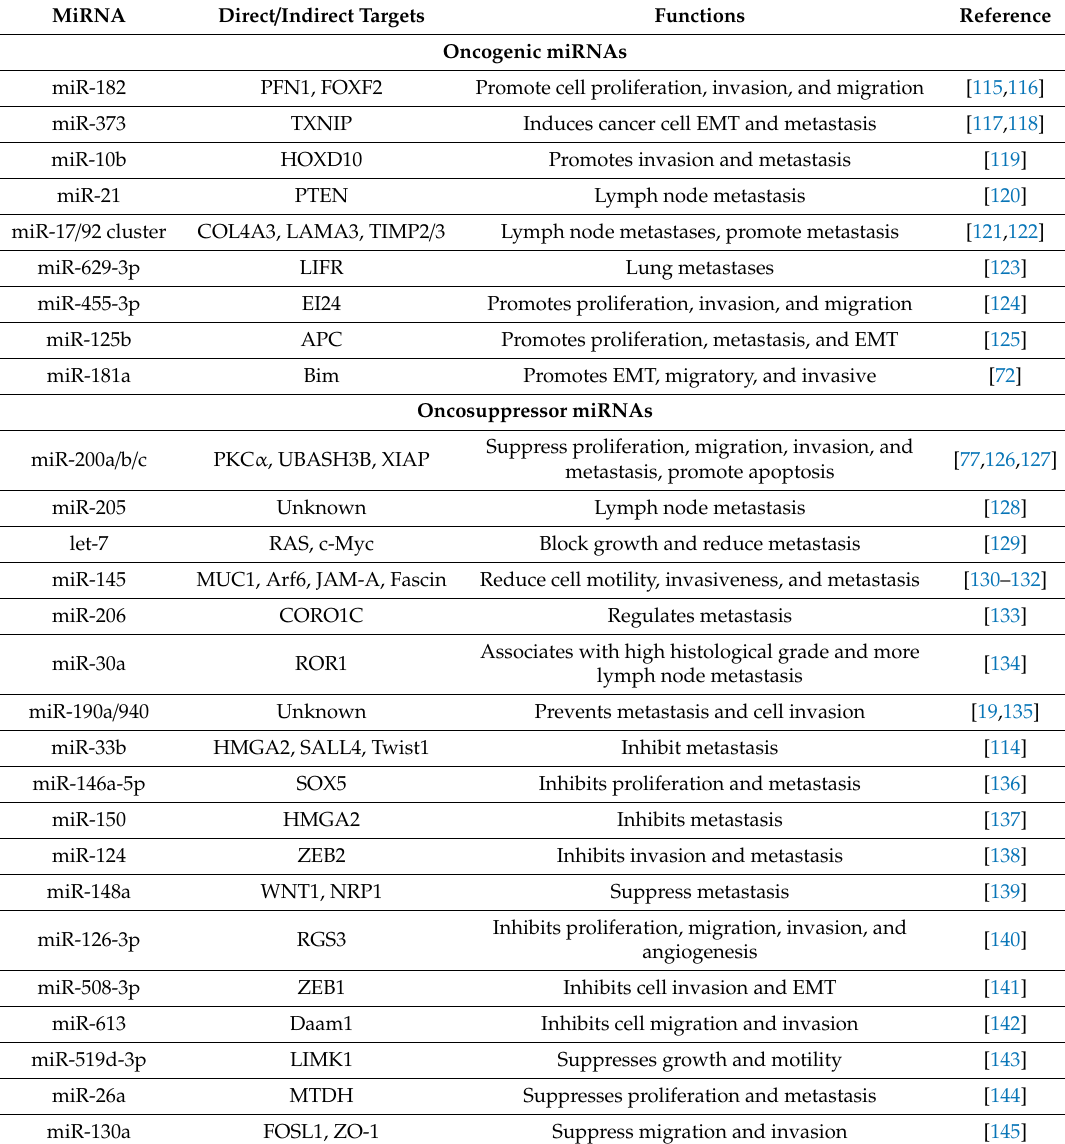
Table 5. MiRNAs associated with metastasis in